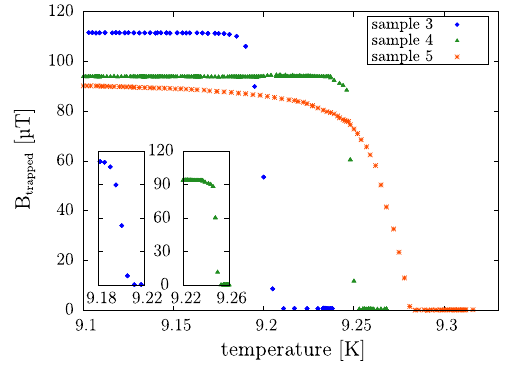
FIG. 7. Release of the trapped field during warm-up: The tempered single crystal samples released the trapped field over a broad temperature